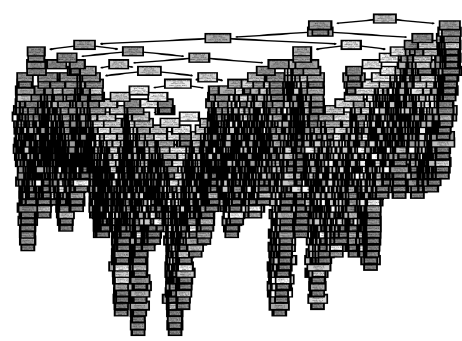
Figure 4. RF for the number of trees n = 100 in our